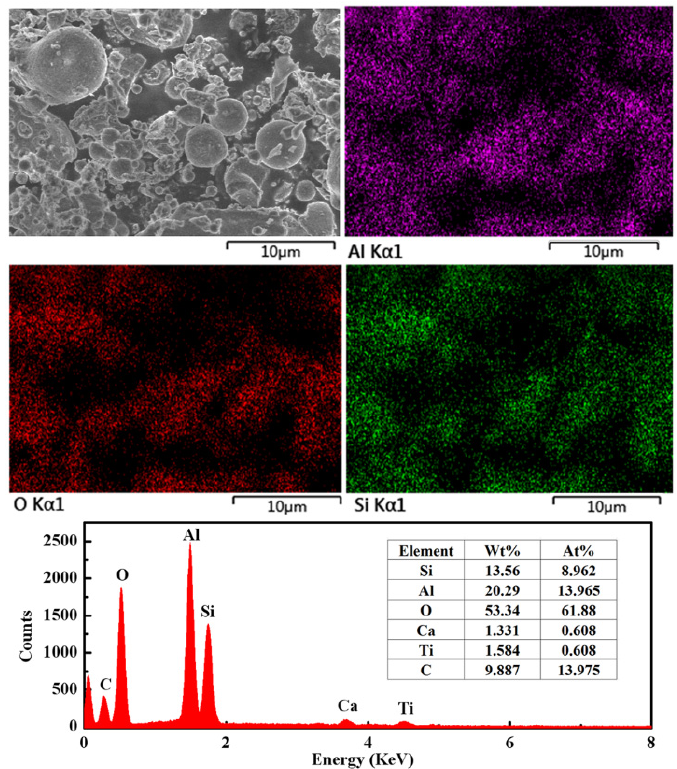
Figure 12. SEM and energy-dispersive spectroscopy (EDS) images of CFA.